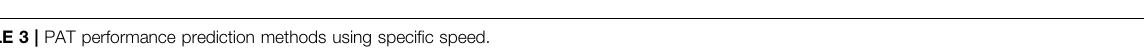
TABLE 3 | PAT performance prediction methods using speci fi c speed. Authors Formula Criterion ( C ) (Williams, 1994) Grover (Grover,